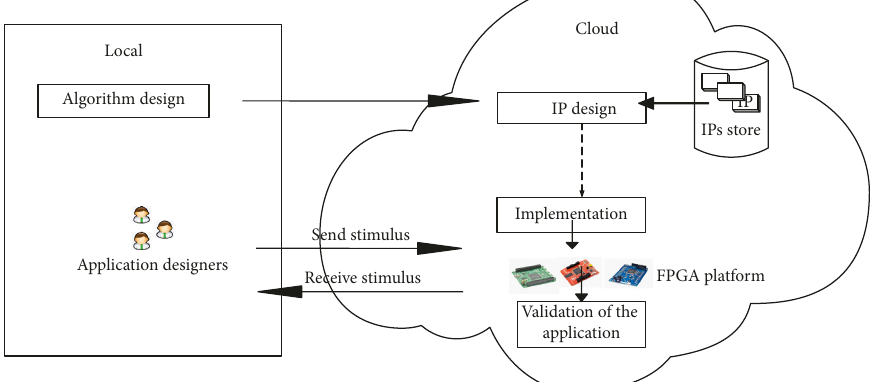
Figure 6: New service in the cloud of